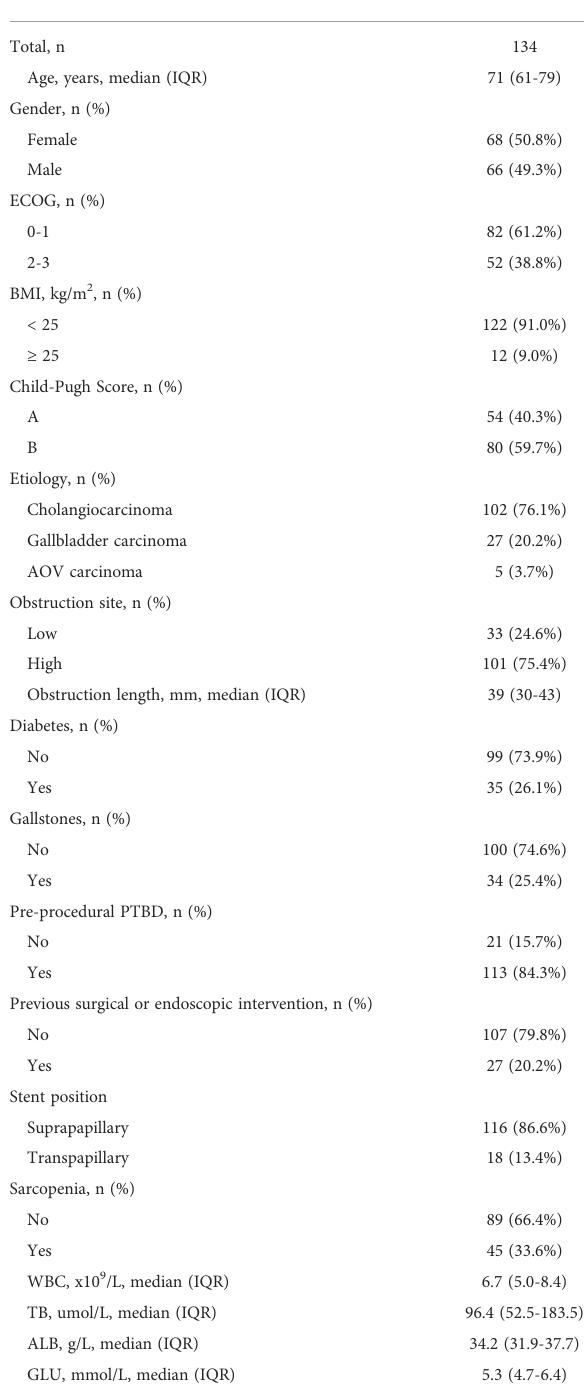
TABLE 1 Baseline characteristics of included